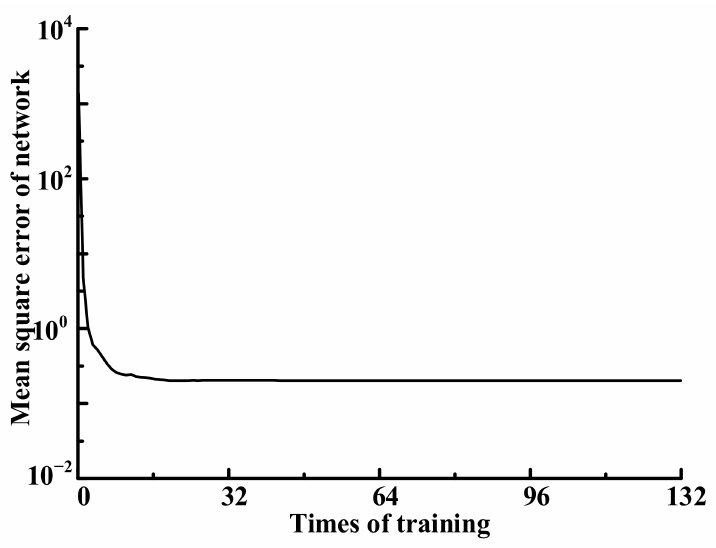
Figure 18. Training performance of the neural